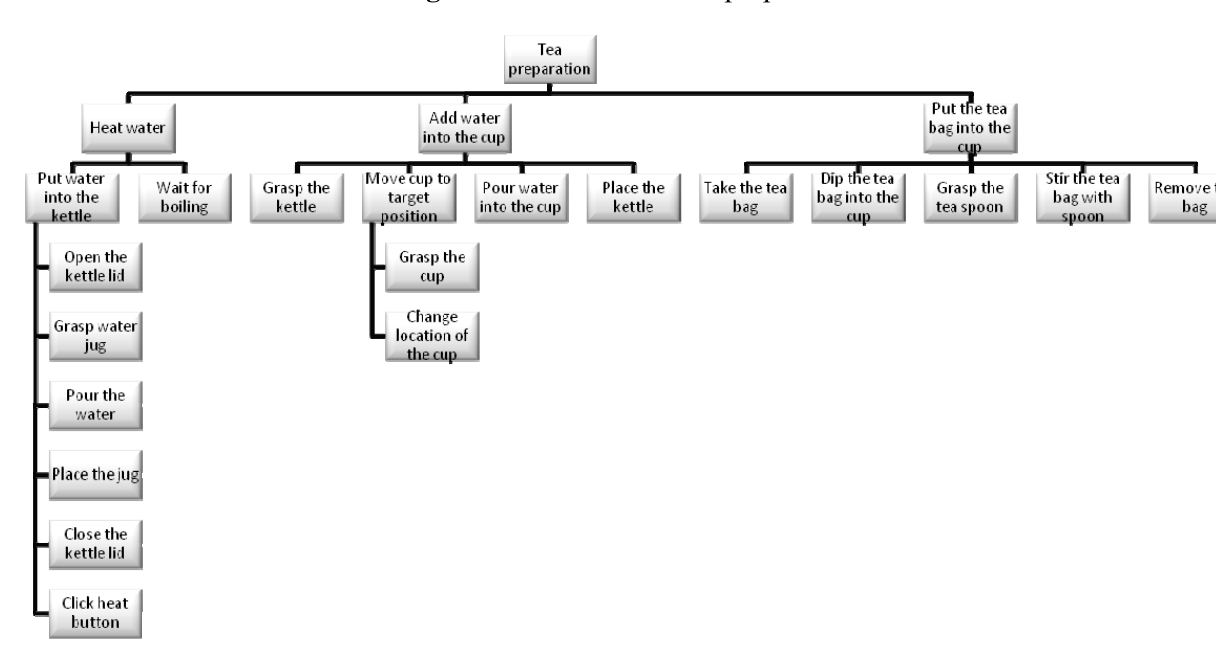
Figure 4. Task tree for tea